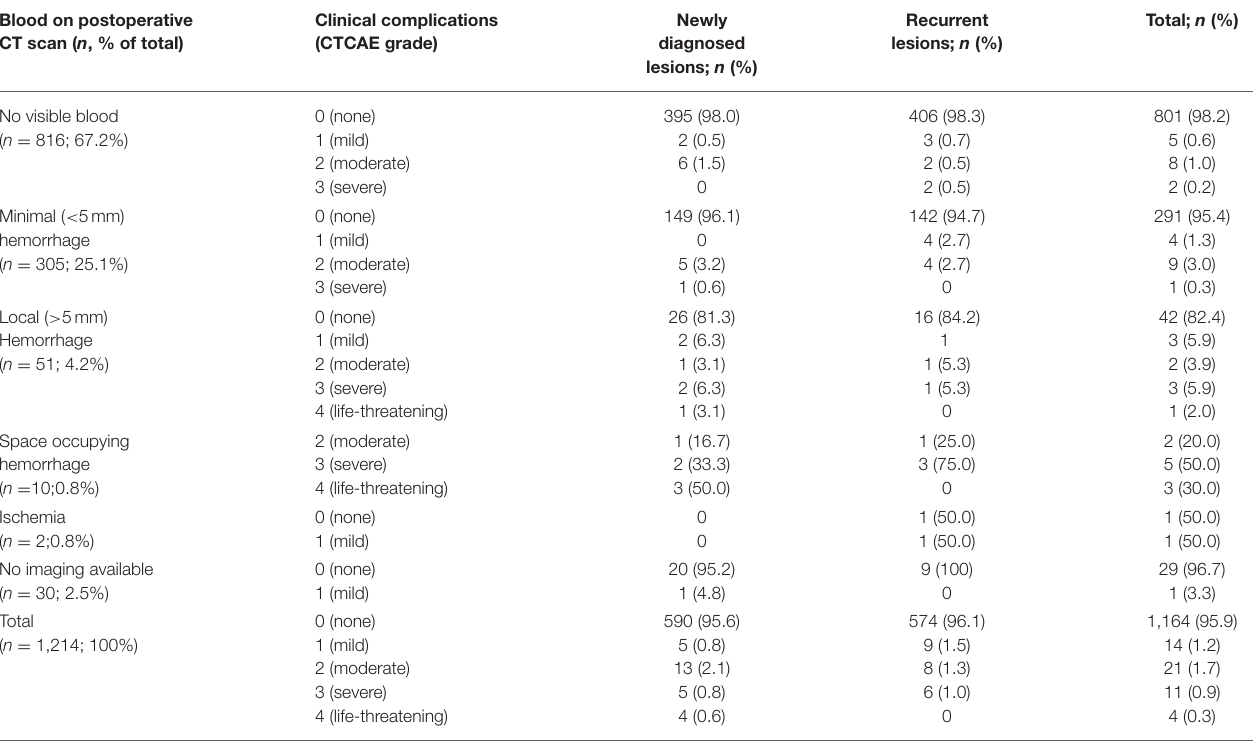
TABLE 3 | Complications according to postoperative imaging and severity. Blood on postoperative CT scan ( n , % of total)